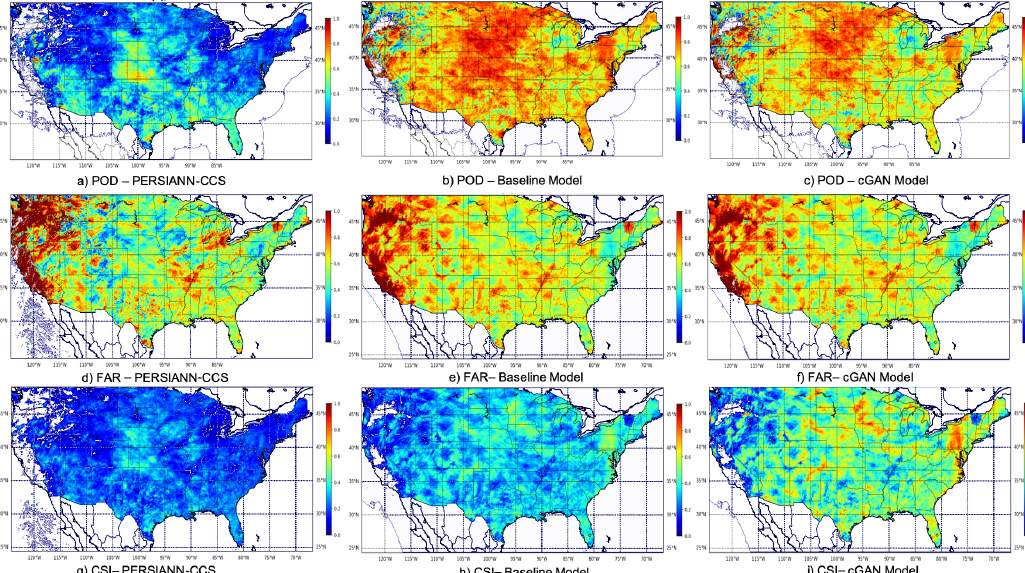
Figure 7. POD ( top row ), FAR ( middle row ) and CSI ( bottom row ) of PERSIANN-CCS ( left column ), the baseline model ( middle column ) and the cGAN model ( right column ) over the United States for July 2018.